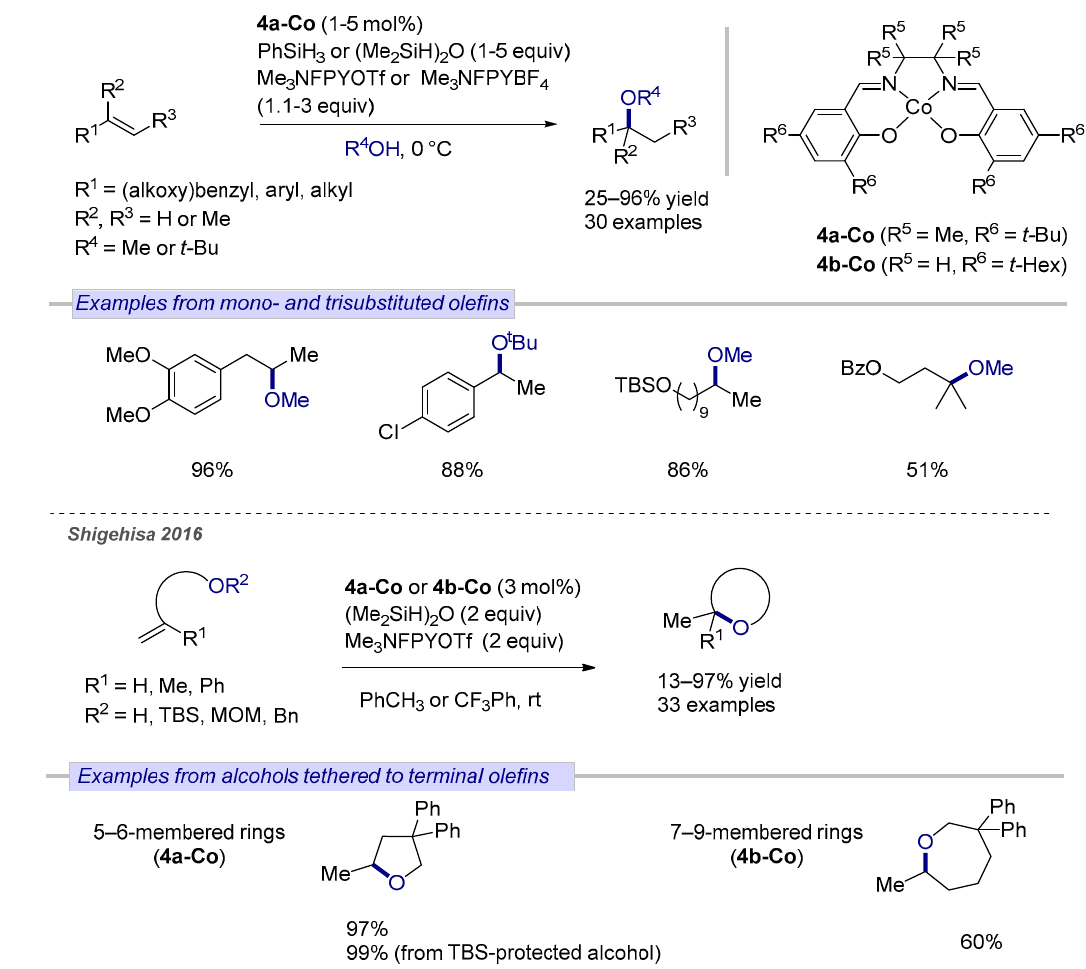
Figure 10. Co-salen promoted hydroalkoxylation of unactivated alkenes. rt = room temperature. 10 In 2018, using a similar Co–H mediated HAT/radical-polar crossover strategy, the group of Pronin reported a Co-Schiff base-catalyzed hydrofunctionalization of tertiary allylic alcohols that, under ligand control, selectively produces either the correspond- ing epoxides or semipinacol rearrangements products (Figure 11) [87]. Cyclohexanol (but not cycloheptanol or cyclopentanol) derivatives and 2-methylbut-3-en-2-ol form the corresponding epoxides in yields up to 69% when Co-salen 4c-Co is employed under the reactions conditions described in Figure 11 (top). Interestingly, switching the 1,2- diphenylethylenediamine backbone of the salen ligand by 2,3-dimethylbutane-2,3-diamine or replacing the p - tert -butyl substituents of the catalyst by nitro groups leads to a change in reaction outcome and allows the efficient formation of the corresponding ketone products from semipinacol rearrangement. This strong ligand-dependence of the hydrofunctional- ization outcome and additional experiments suggest that the epoxidation reaction involves alkylcobalt(IV) complexes as electrophilic intermediates. Recently, the same research